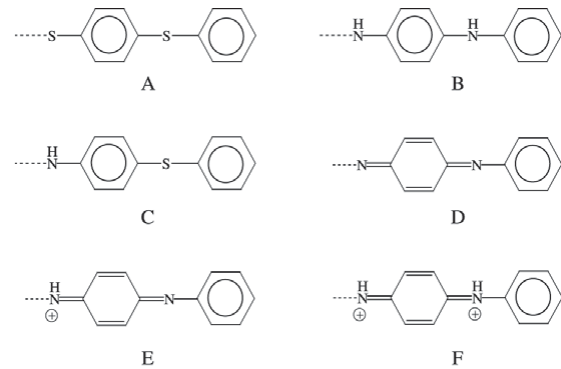
Figure 1. Possible structural monomeric units for copolymers of PPS with PANI. PPS (A); PANI (B – leucoemeraldine form; D – pernigraniline form; E and F – polaronic and bipolaronic struc- tural defects), and PPSA (C). Figure 2. Flow chart of micro Genetic Algorithm used on this